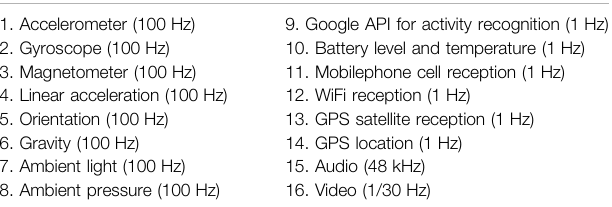
TABLE 1 | Sensor modalities (sampling rate) in the complete SHL dataset.